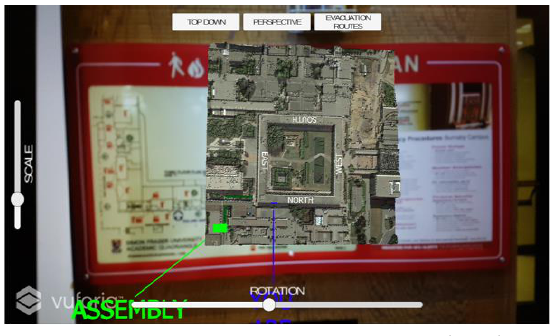
Figure 5. AR evacuation plan visualization (nadir)